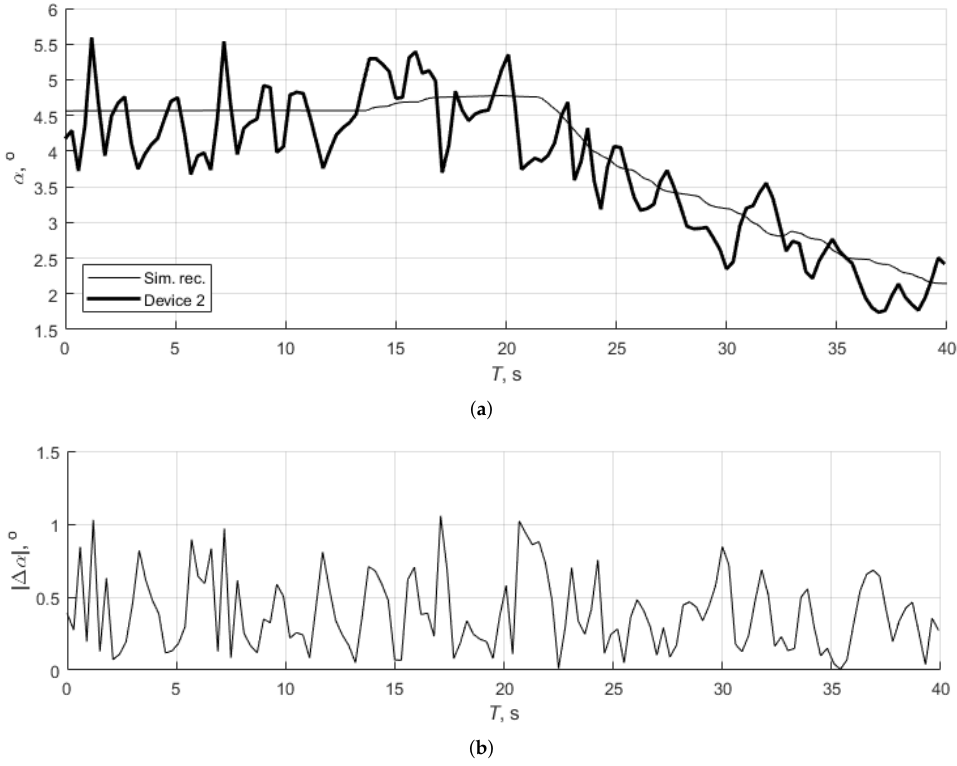
Figure 6. The estimated AoA: ( a ) from the flight simulator “Sim.rec.” and test flight data “Device 2”; ( b ) absolute difference between the “Sim.rec.” and “Device 2”.